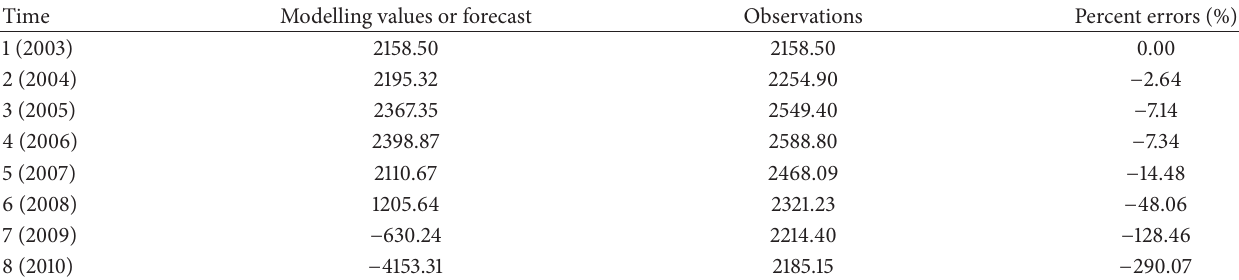
emissions by GMC (1, 2). 2